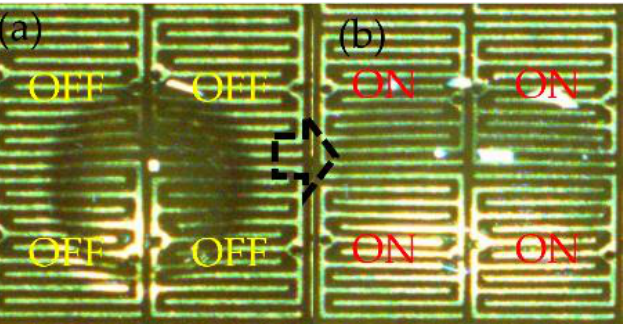
Figure 5. Droplet manipulation control flow. ( a ) Set up the droplet at the center of four electrodes. ( b ) Switch on four electrodes at the same time for the droplet to be stretched.